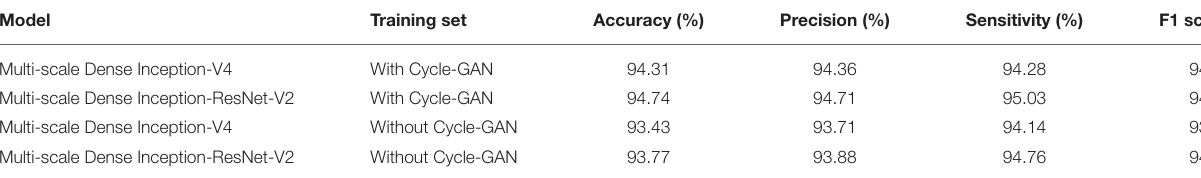
TABLE 2 | Test results on different datasets.